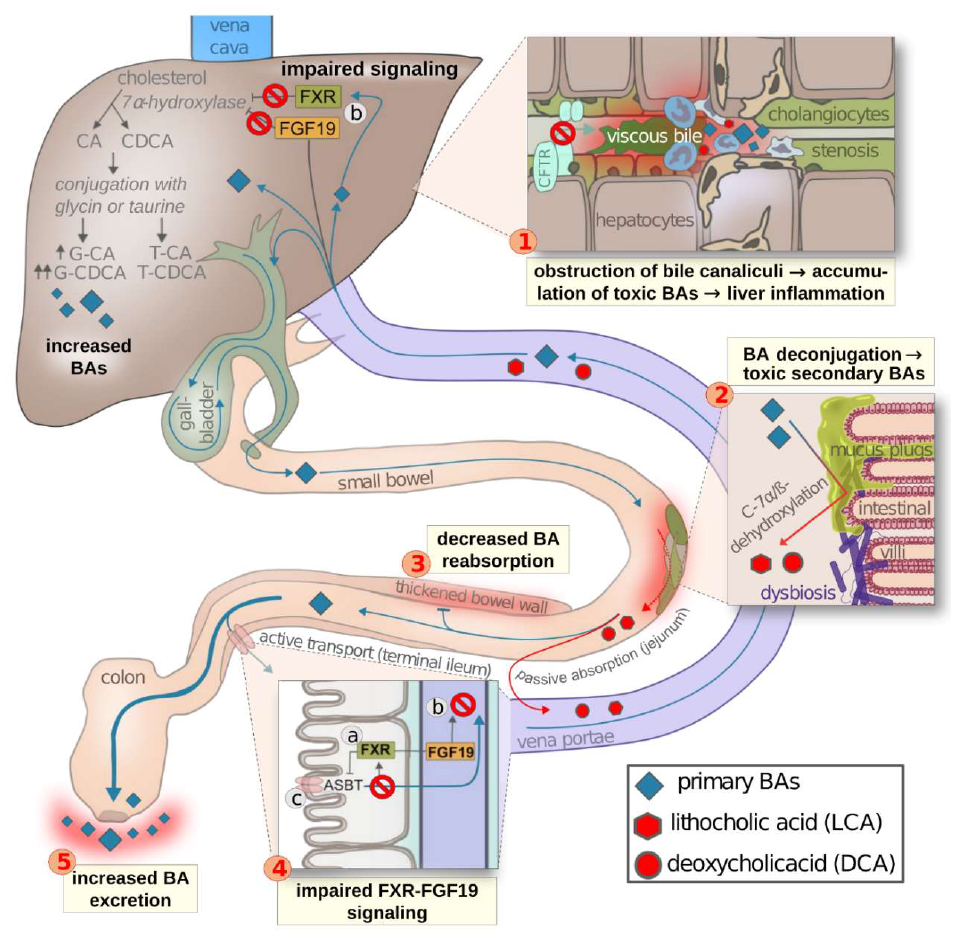
Figure 1. Physiological bile acid production and enterohepatic circulation, including proposed mechanisms of alterations related to CFTR deficiency (in red). ( 1 ) CFTR dysfunction on the apical side of the cholangiocytes leads to secretion of bile with high viscosity, occluding the bile canaliculi. Cystic fibrosis liver disease (CFLD) is caused by accumulation of hydrophobic, toxic, glycine-conjugated BA promoting neutrophil activation and inflammation, which damages hepatocytes and bile ducts. ( 2 ) Mucus plugs and dysbiosis due to increased acidity, antibiotic use, and swallowed contaminated saliva promote deconjugation of BAs, resulting in higher concentrations of toxic secondary BAs (LCA, DCA) and decreased enteric BA reabsorption (enterohepathic circulation). ( 3 ) Impaired BA resorption caused by bowel wall thickening. ( 4 ) ( a ) Active resorption of BAs activates FXR, stimulating the synthesis of FGF19. ( b ) FGF19 exerts negative feedback on 7-alpha-hydroxylase, the key enzyme in BA synthesis. ( c ) FXR activation is also hypothesized to down-regulate ASBT channels. BA malabsorption in CF results in impaired FXR-FGF19 signaling. ( 5 ) Increased fecal BA excretion in CF (BA losses). BA: bile acid; ASBT: apical sodium-dependent bile acid transporter; FXR: farnesoid X receptor; FGF19: fibroblast growth factor 19; LCA: lithocholic acid; DCA: deoxycholic acid; CA: cholic acid; G-CA: glycocholic acid; T-CA: taurocholic acid; CDCA: chenodeoxycholic acid; G-CDCA: glycochenodeoxycholic acid; T-CDCA: taurochenodeoxycholic acid. [Image by Anton